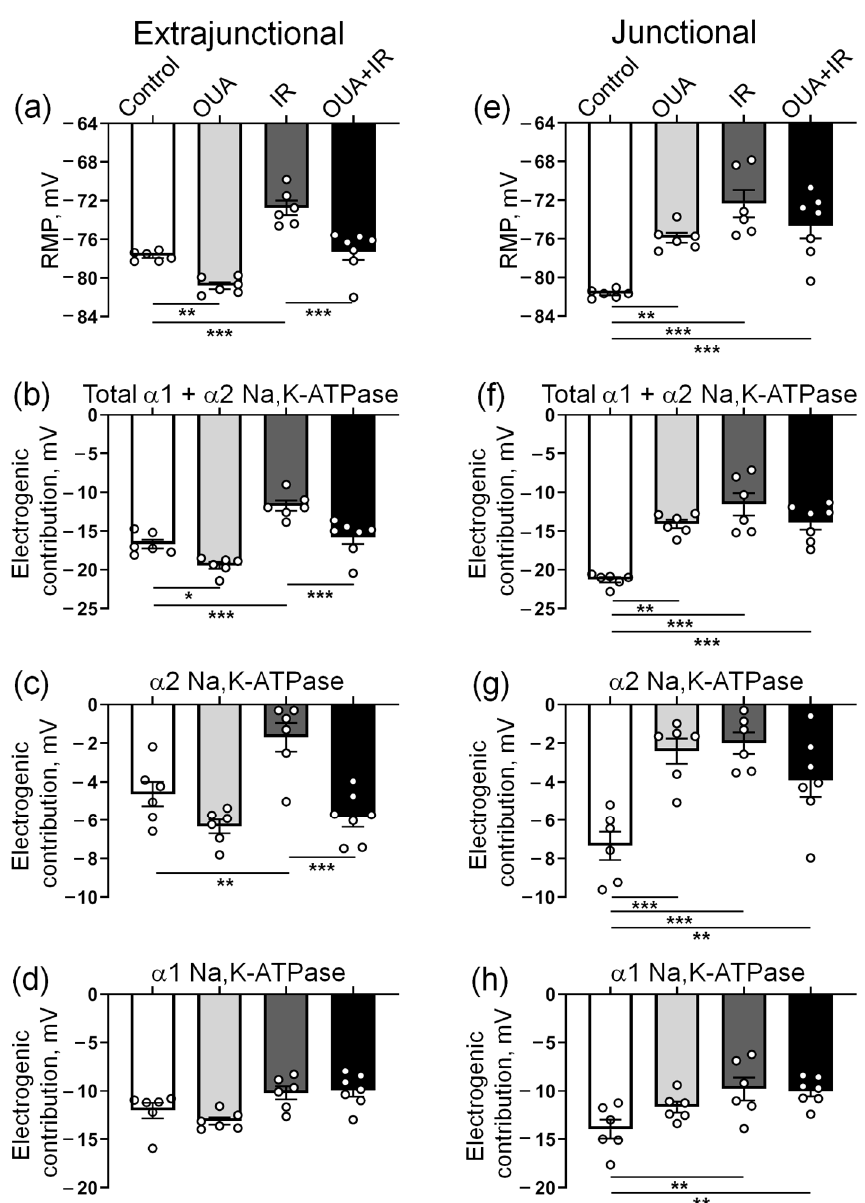
Figure 5. The Na,K-ATPase-dependent membrane potential changes in the extrajunctional ( a – d ) and junctional ( e – h ) regions of the sarcolemma of diaphragm muscle from control rats, rats chronically treated with ouabain (OUA), rats exposed to ionizing radiation (IR), and rats chronically treated with ouabain and exposed to IR (OUA+IR). ( a , e ) Resting membrane potential (RMP). ( b , f ) Total electrogenic contribution of the Na,K-ATPase was measured as the sum of electrogenic activities of the α 2 and α 1 isozymes of Na,K-ATPase. ( c , g ) Electrogenic contribution of the α 2 Na,K-ATPase as membrane potential changes in the presence of 1 µ M ouabain. ( d , h ) Electrogenic contribution of the α 1 Na,K-ATPase as membrane potential changes in response to the sequential addition of 500 µ M ouabain to the bath solution. The number of muscles corresponds to the number of symbols; n = 6 − 7 in all groups. *, **, and ***, p < 0.05, 0.01 and 0.001 (two-way ANOVA followed by Bonferroni